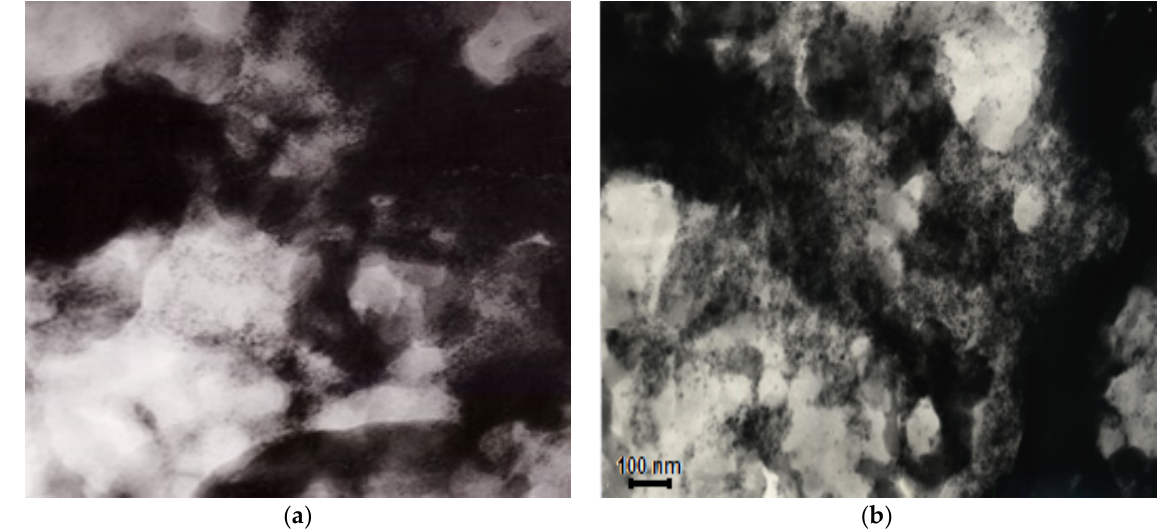
Figure 2. TEM patterns of 5%Co-Rh(95:5)/Al 2 O 3 catalyst: ( a ) fresh and ( b ) used samples.